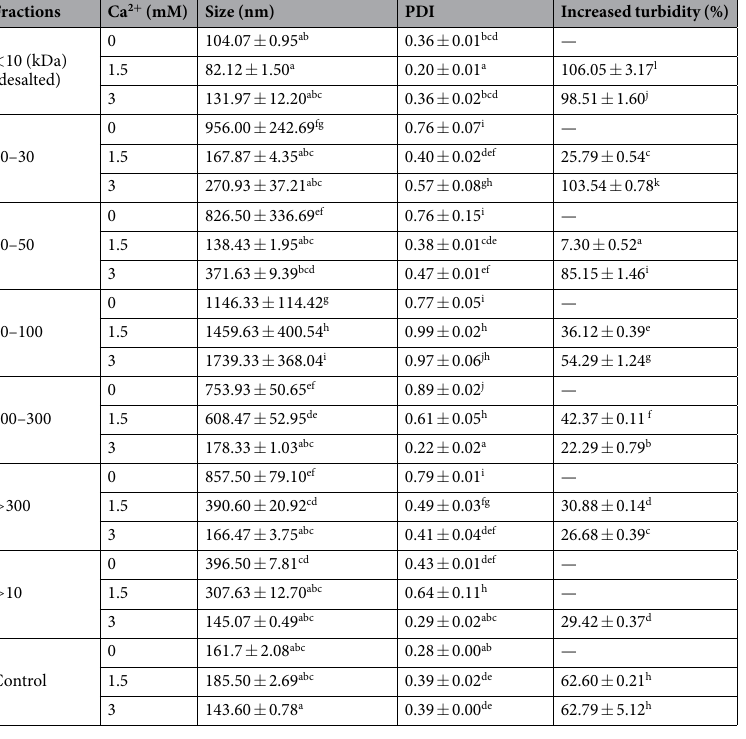
Table 1. Effect of Ca 2 + concentration on the suspension turbidity, particle size, and polydispersity (PDI) of cruciferin particles that were formed under different molecular weights. Values within the same row that do not share a common superscript letter are significantly different (p < 0.05). Control was unfractionated